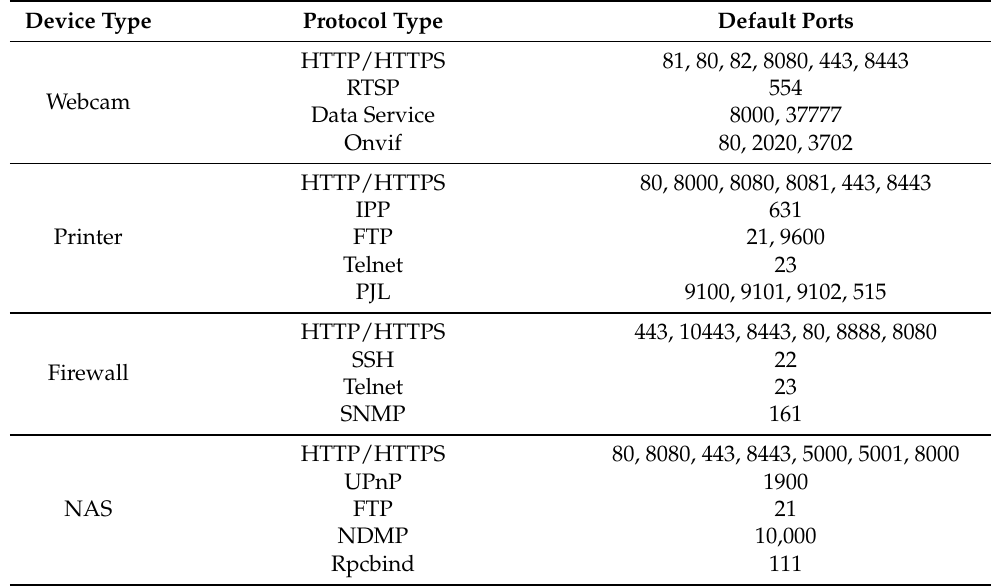
Table 1. Typical open port